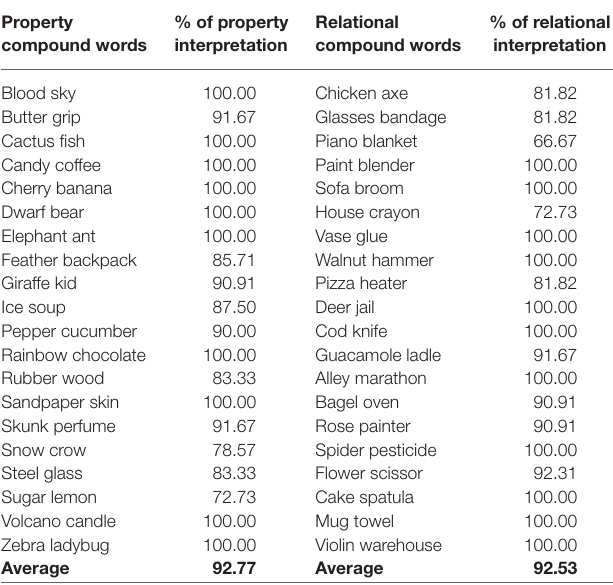
TABLE 1 | Interpretation bias of property and relational compounds in Experiment 1 and 2. Property compound